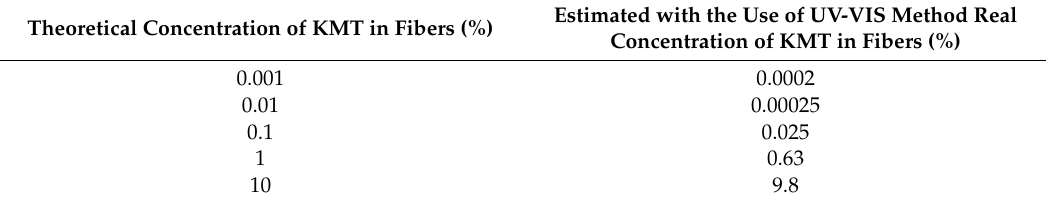
Table 2. Results of the real content of KMT in fiber examination.